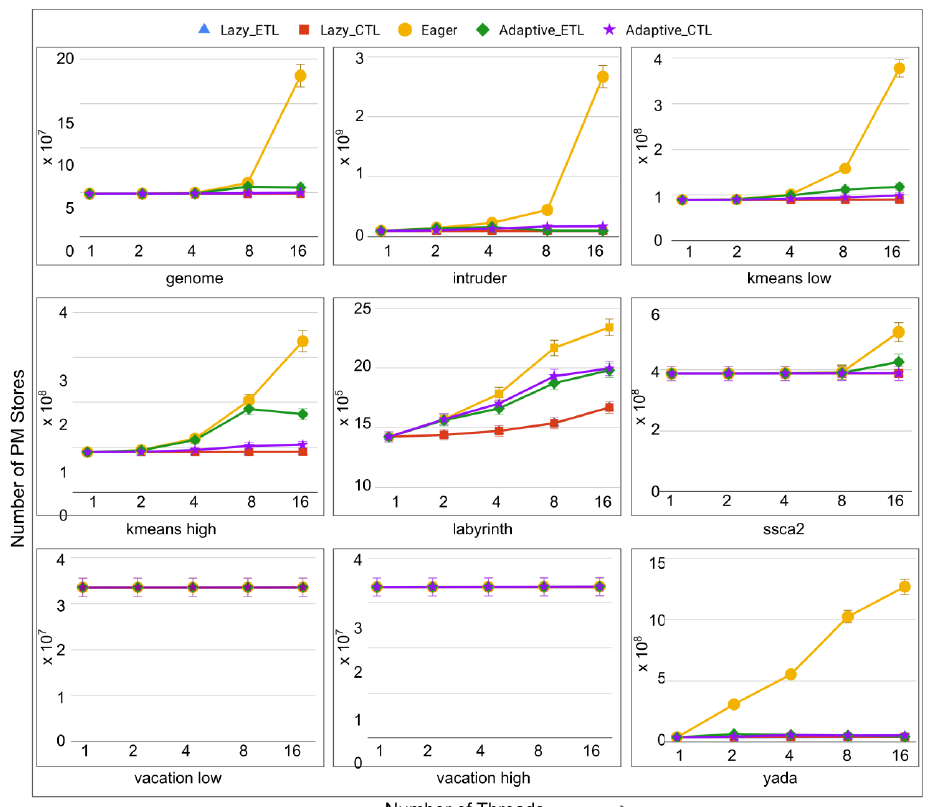
Figure 11. Total number of stores to the PM in STAMP